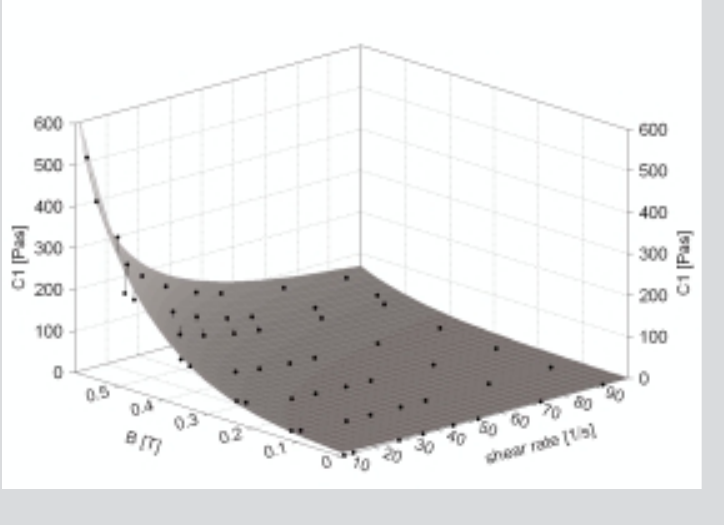
Table 1 (above): Fluid parameter C 2 as a function of the magnetic field B. Table 2 and Figure 9 (below): Fluid parameter C 1 as a function of the magnetic flux density B and the shear